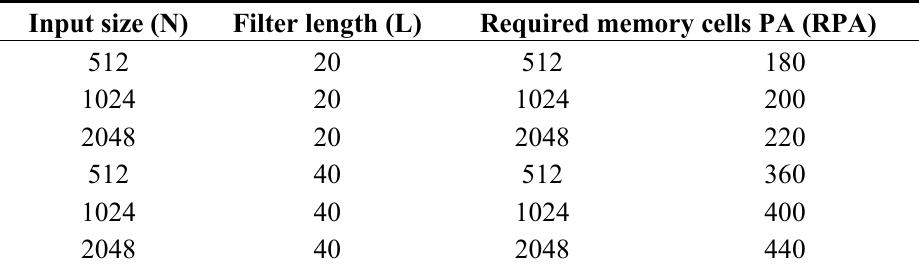
Table 2. Comparison of required numbers of memory cells for the pyramid algorithm (PA) and the recursive pyramid algorithm